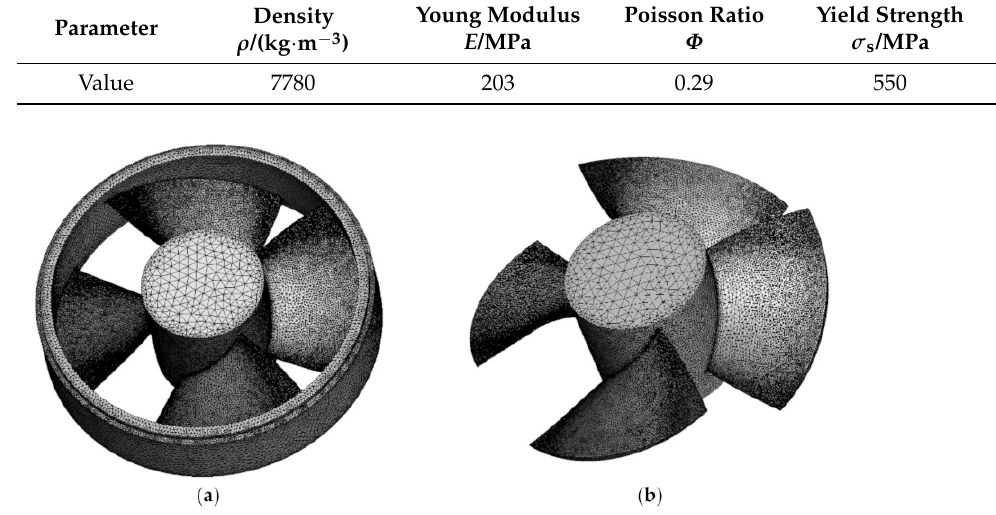
Figure 4. The grid of the impeller structure: ( a ) the full tubular pump impeller grid, ( b ) the axial-flow pump impeller